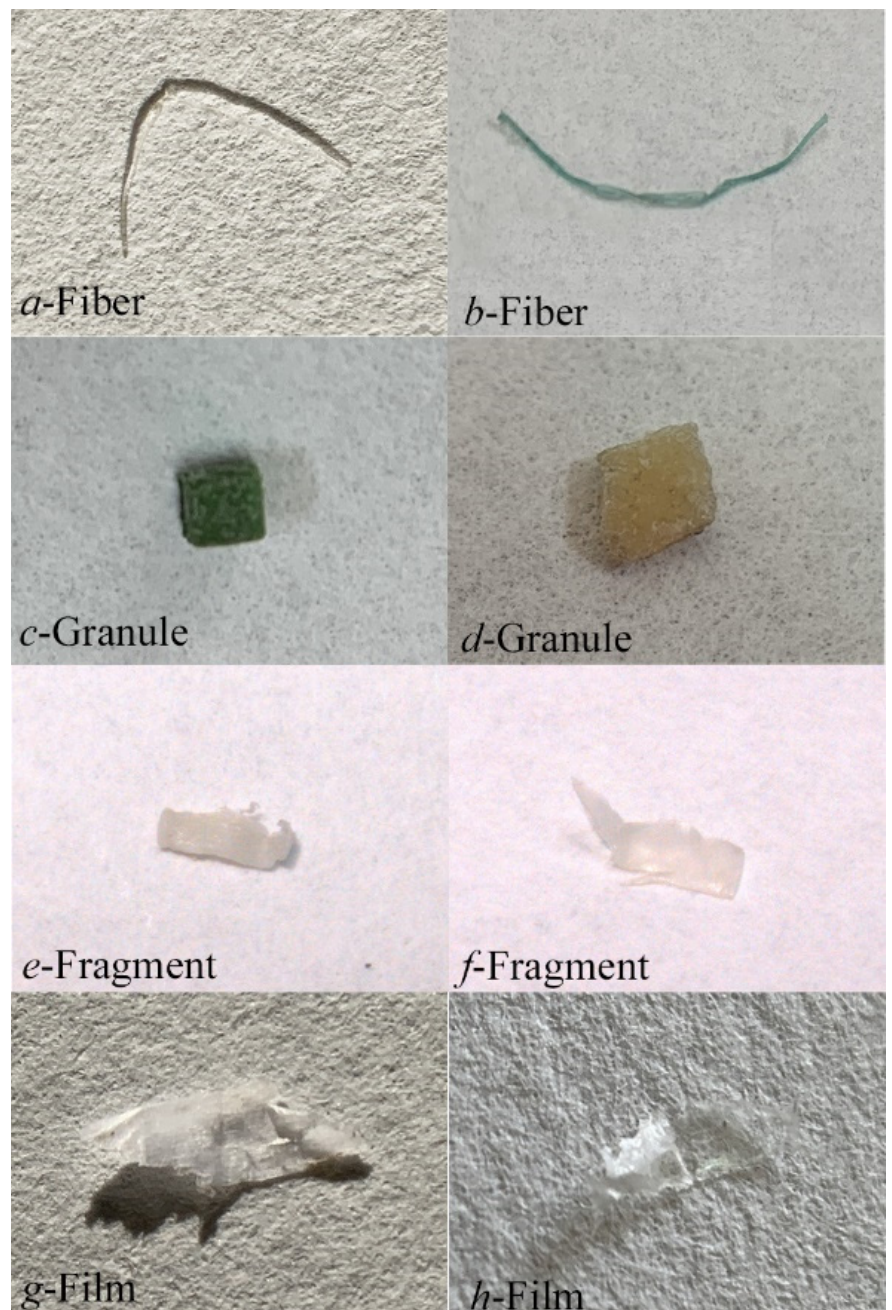
Figure 4. Photographs of typical MPs of varying shape collected from surface waters in a coastal region of the PRE: ( a , b –Fiber, c , d –Granule, e , f –Fragment, g , h –Film).